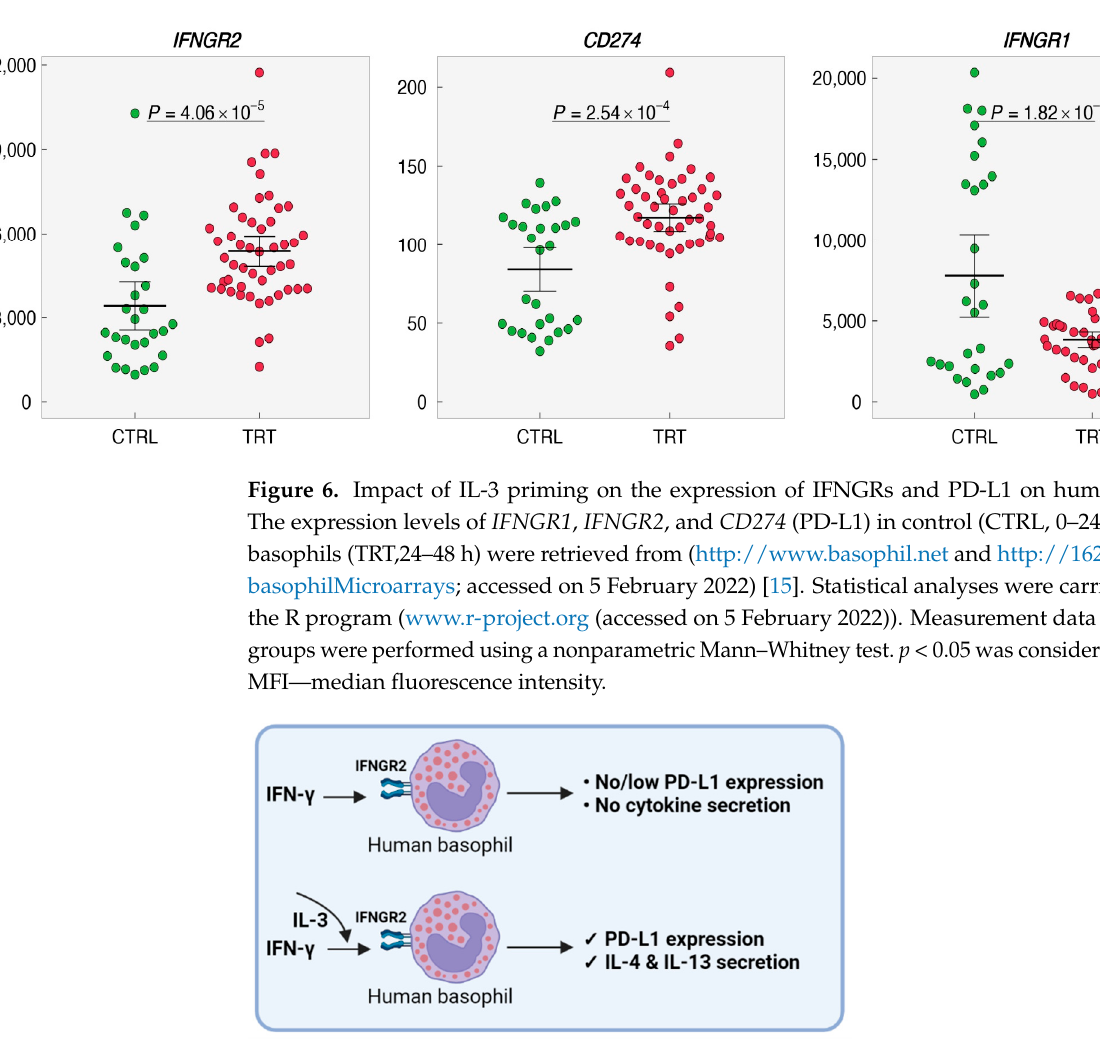
Figure 7. IFN- γ -induced PD-L1 expression in human basophils.